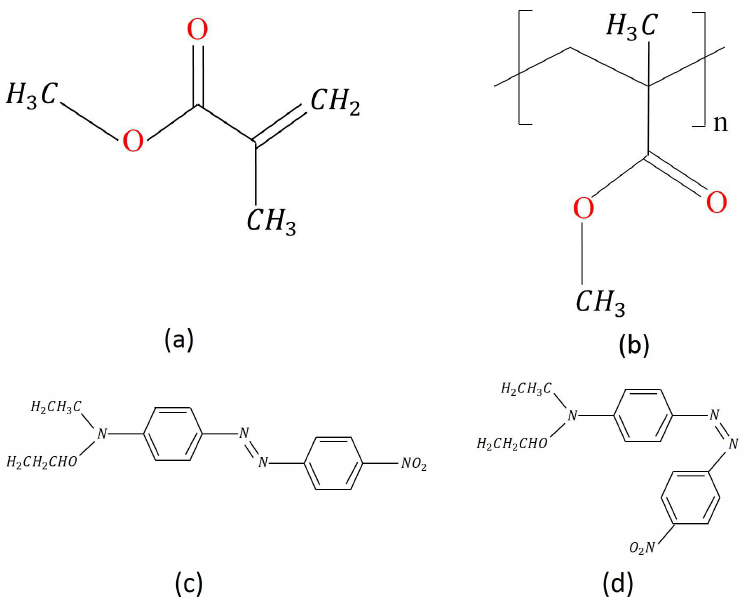
Figure 4. Chemical structures of ( a ) Methyl Methacrylate (MMA), ( b ) Poly (Methyl Methacrylate) (PMMA), ( c ) Disperse Red 1 (DR1) trans isomer, and ( d ) Disperse Red 1 (DR1) cis